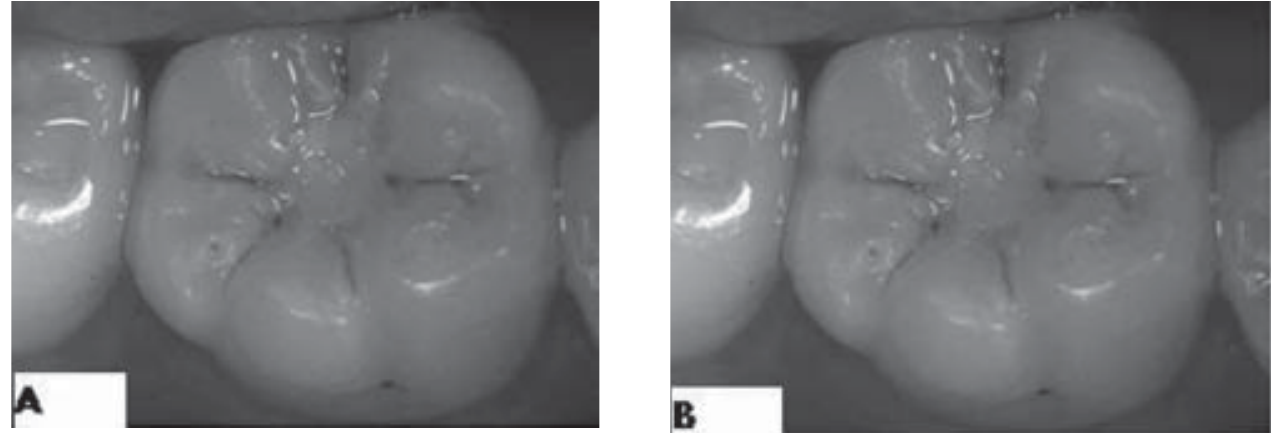
Fig. 3A and 3B - Packable composite resins restorations after 2 years of evaluation, showing Bravo score for marginal staining, according to USPHS criteria.